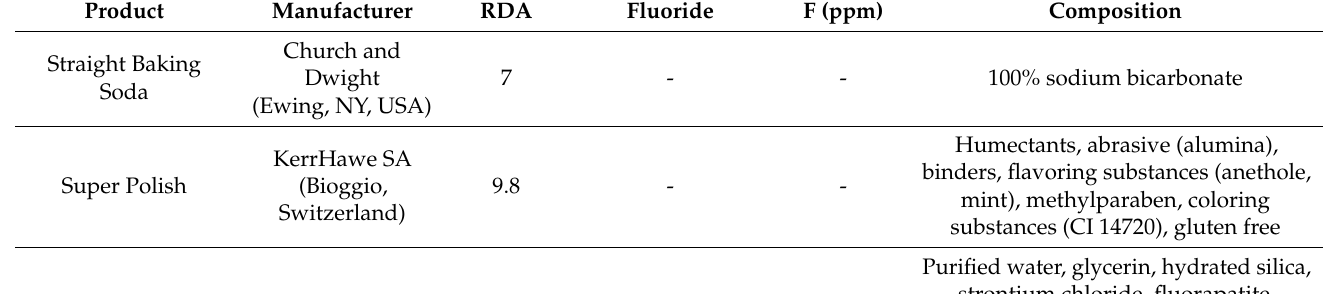
Table 1. Materials used and their